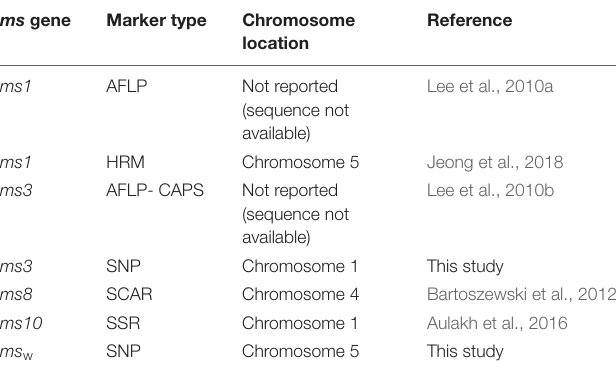
TABLE 4 | Markers reported for non-allelic nuclear male sterile genes in